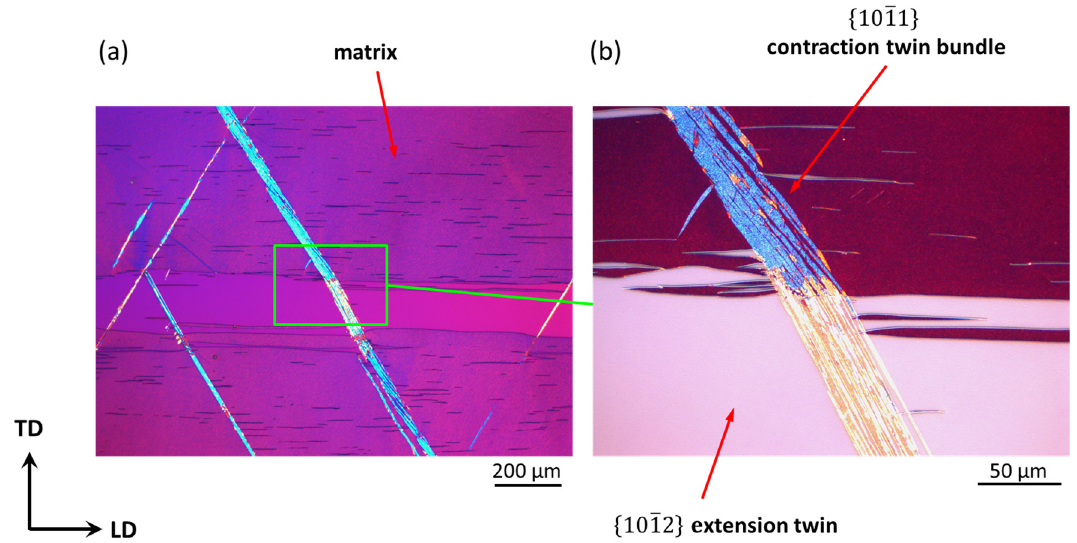
Figure 17. Optical micrographs after PSC tests at room temperature of crystals with orientation F at a true strain of − 5.5% after the drop in strain hardening (Figure 14). ( b ) is a magnified view of the center region in ( a ).